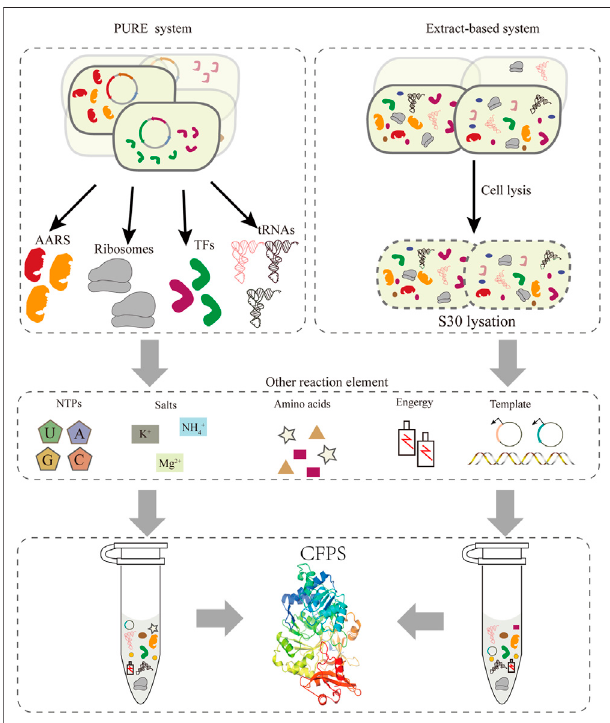
FIGURE 2 | Two strategies exist for implementing CFPS: the PURE system and the extract-based system. In the PURE system (left), each essential factor associated with protein translation is puri fi ed separately from overexpressing cells, including aaRS, ribosomes, translation factors, tRNAs, etc. In addition, the corresponding template and reaction buffer components are added to construct a functional translation system. The extract-basedsystem(right)issimpleandrapid,sinceitreliesonpreparingthe native cellular extract by lysing cells.